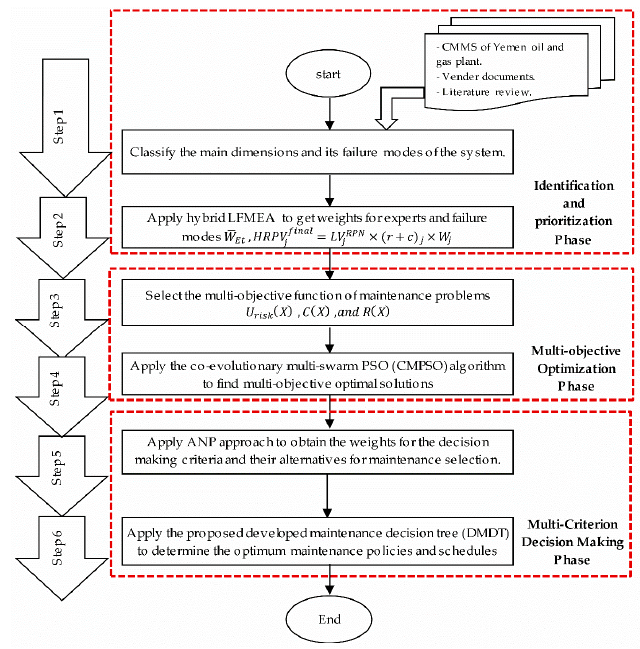
Figure 1. The proposed model for reliability-centered maintenance.